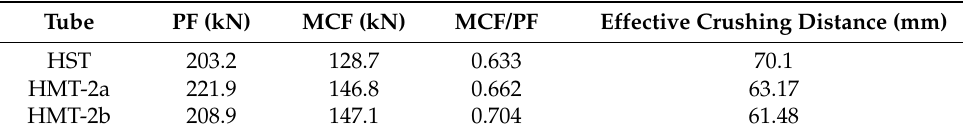
Table 3. Experimental crushing resistance based on local MCF curve.